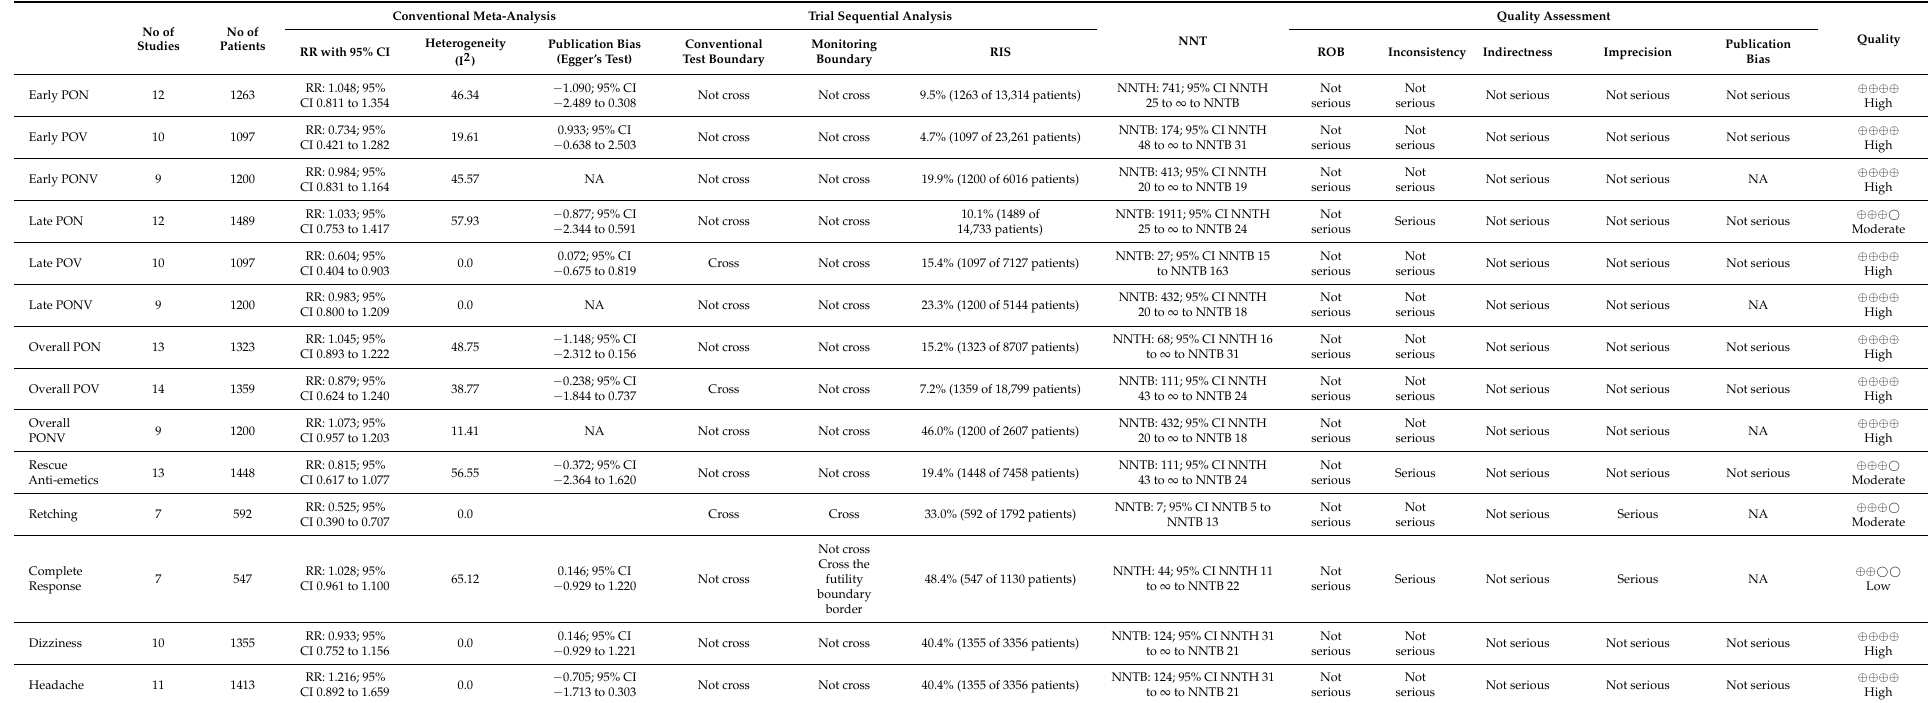
Table 4. The results of meta-analysis and GRADE evidence quality for each